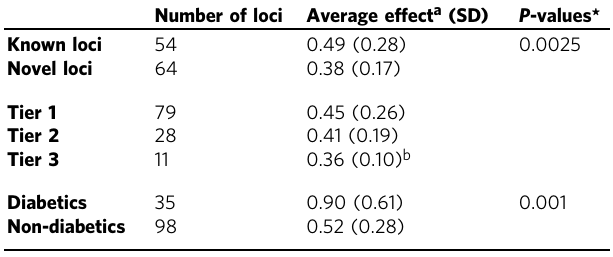
Table 2 Summary of signi fi cant known and novel loci from analysis of common variants